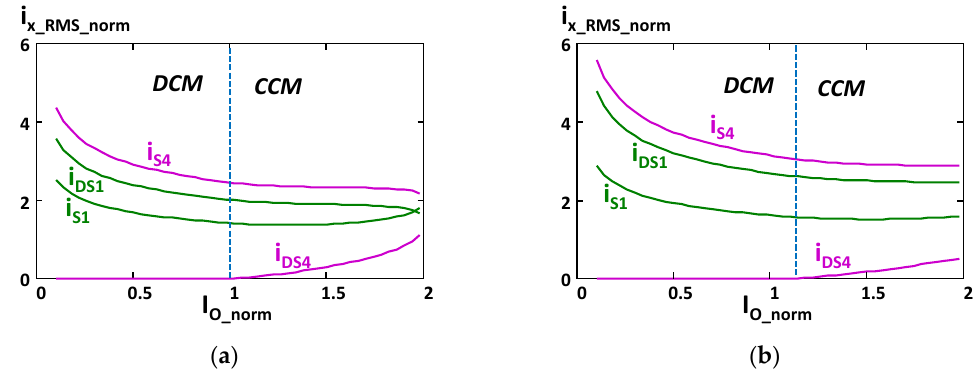
Figure 8. Normalized rms values of the current through the semiconductors of the primary bridge. The converter is designed to enter in DCM at half of the maximum output current at the maxi- mum normalized voltage conversion ratio; N = N max . d max is limited at 0.48. ( a ) N = N max and ( b ) N = 0.8 · N max